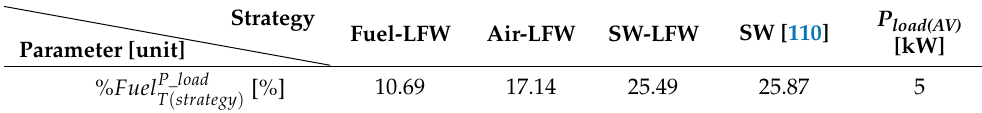
Table 10. Percent of fuel economy for the third load profile in case of k eff = 25 and P ref = 4.5 kW Strategy Parameter [unit]